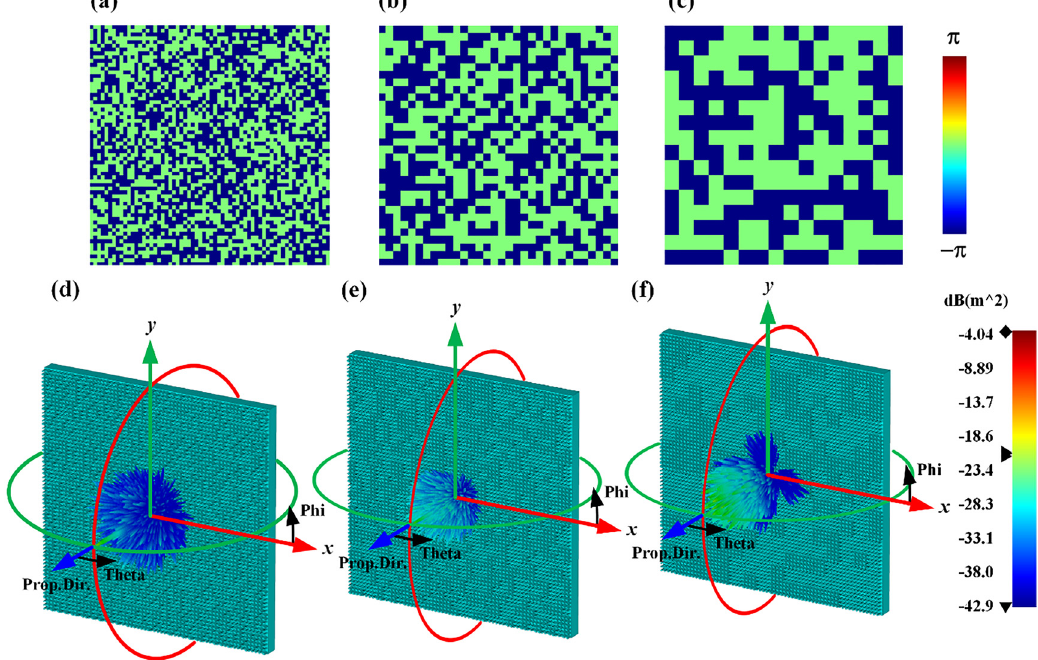
Figure 4: Simulated 3D scattering patterns for the 1-bit coding metasurfaces contain different super unit cells. (a – c)Thescatteringphaseprofilesforthecodingmetasurfacescontainsuperunitcellsof1 × 1,2 × 2and4 × 4,respectively.(d – f)Simulated3D far- fi eld scattering patterns for the coding metasurfaces contain super unit cells of 1 × 1, 2 × 2 and 4 × 4,